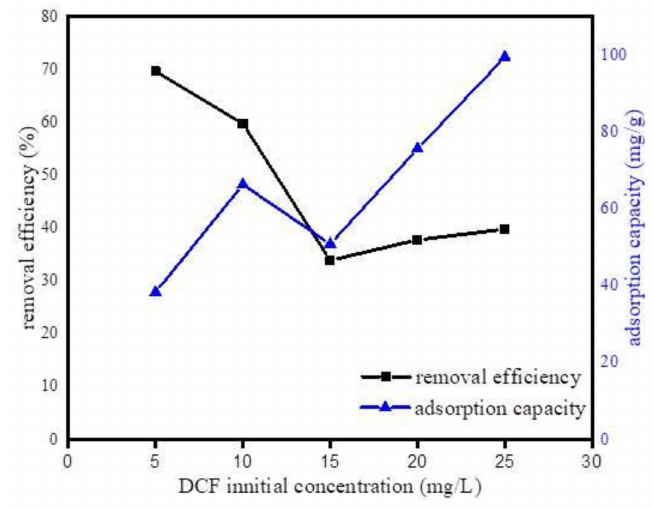
Figure 10. E ff ect of initial concentration of DCF on the uptake of DCF onto